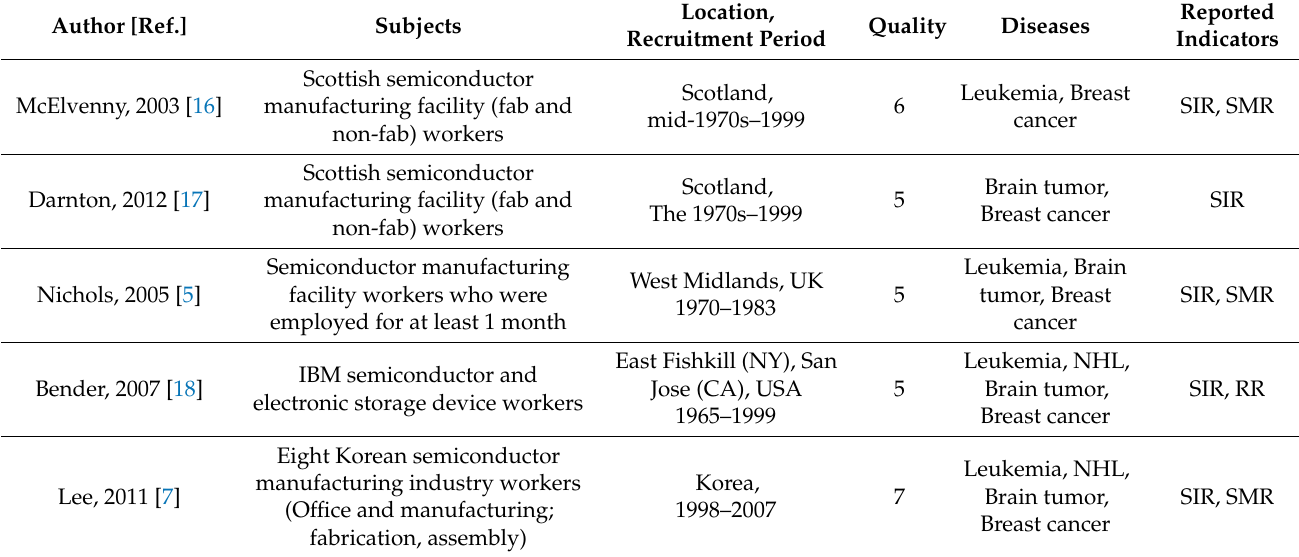
Table 3. Sex-specific meta-analysis for the standardized incidence ratios (SIRs) of cancer, leukemia, NHL, and brain tumor in semiconductor workers compared to the general population.